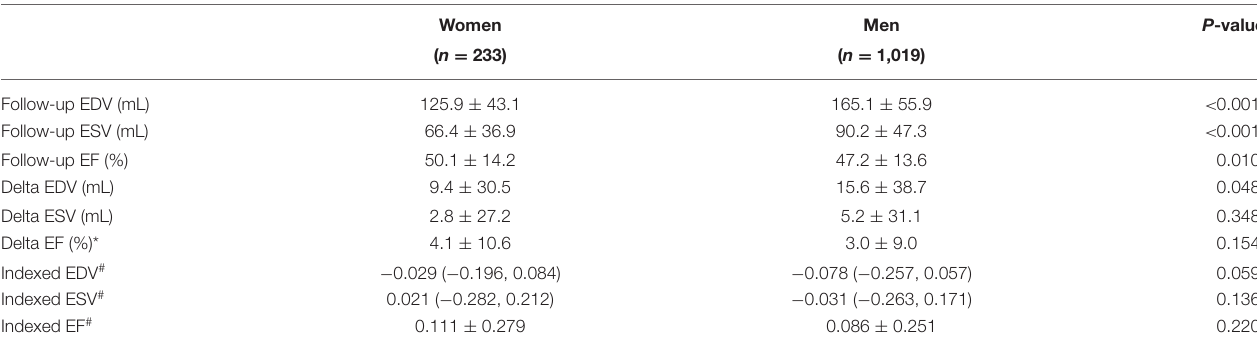
TABLE 5 | Follow-up left ventricular functional data efficacy endpoints stratified by